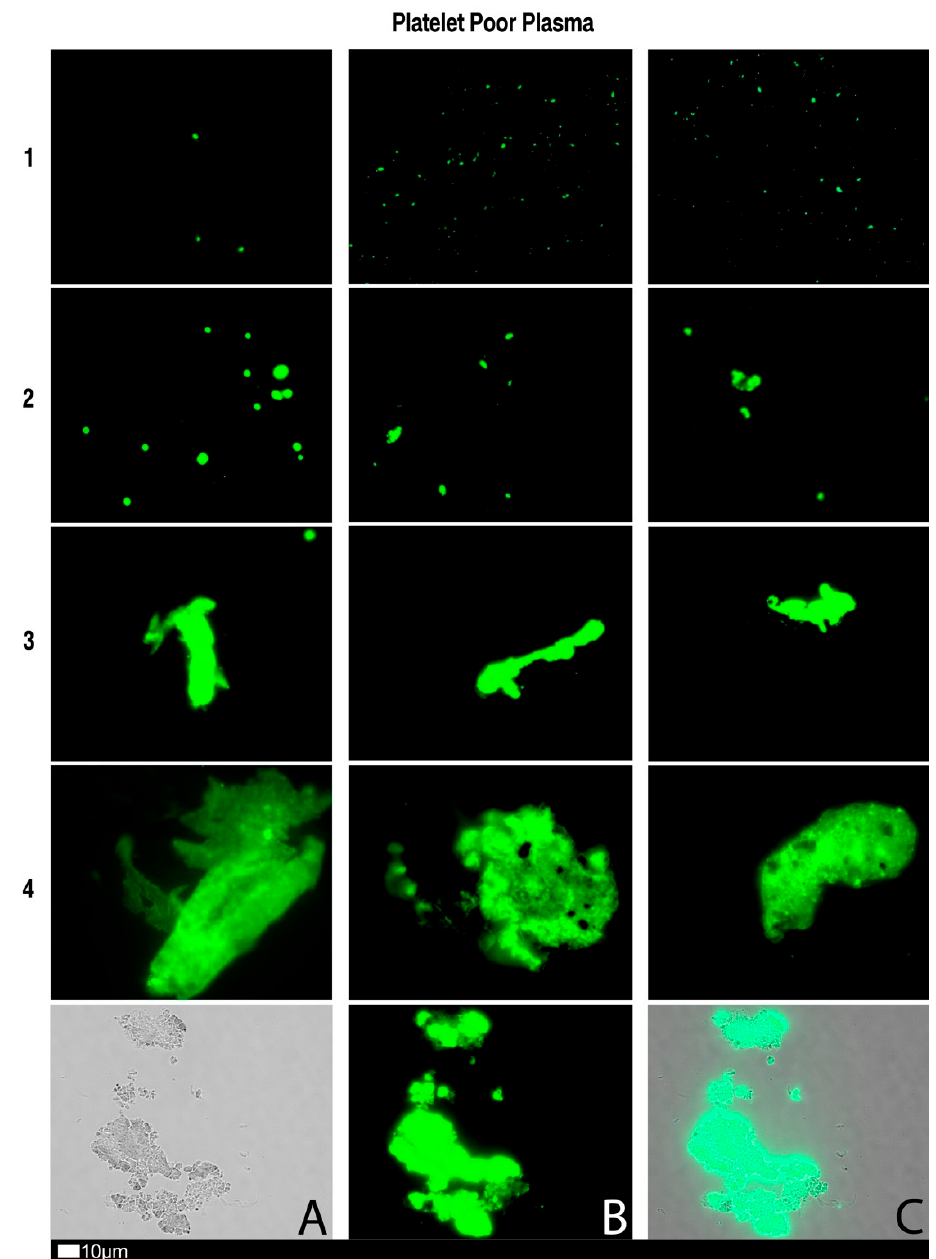
Figure 4. Fluorescence microscopy showing microclots in platelet poor plasma (PPP) with representa- tive examples of the different stages of different stages of microclot formation. Stage 1 shows minimal microclot formation in healthy/control PPP which progresses to the presence of the severe micro- clotting Stage 4. Stage 1 to 4 is also used as a numerical scoring system, where a score of 1 is given for minimal microclot formation and a score of 4 is given for significant and widespread microclot formation. Bottom row represents examples of stage 4 microclots using ( A ) bright-field microscopy, ( B ) fluorescence microscopy, and ( C ) an overlay of fluorescence and bright-field